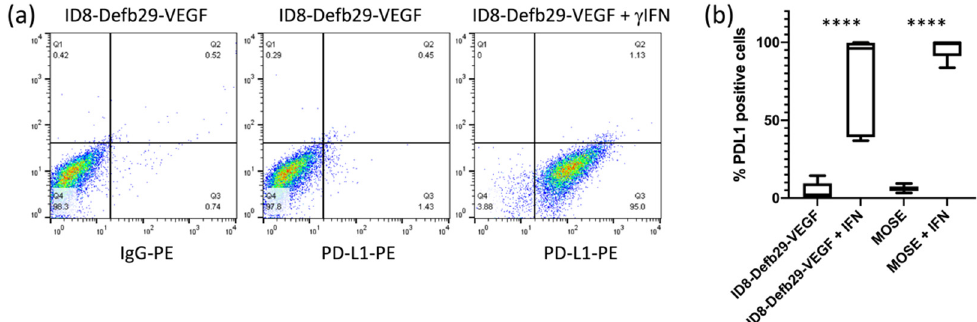
Figure 1. Representative flow cytometry dot plots of ID8-Defb29-VEGF cells without and with IFN- γ ( a ), and percentage of PD-L1-positive ID8-Defb29-VEGF ( n = 10) and MOSE ( n = 9) cells without and with IFN- γ (**** p < 0.0001) ( b ).